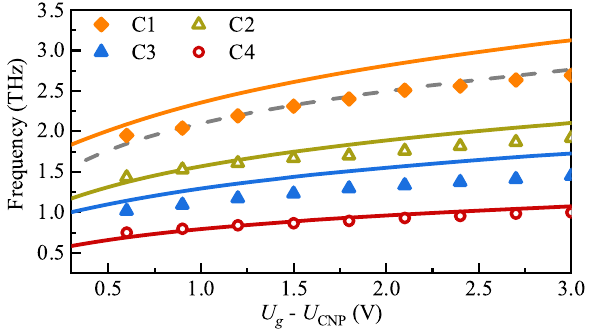
FIG. 7. Gate-voltage dependence of the extracted resonance frequency. Continuous lines are results of calculations according Eq. (7) with corrections to fringing and plasma leakage phenomena — see Supplemental Material [51] for more details. The dotted line is ¼ power dependence as a function of the gate bias, typical for plasmons in